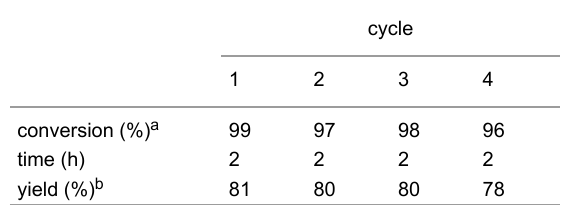
Table 4: Recycling of Fe-Al-MCM-41 catalyst for the reaction of phenol with phenylacetylene.